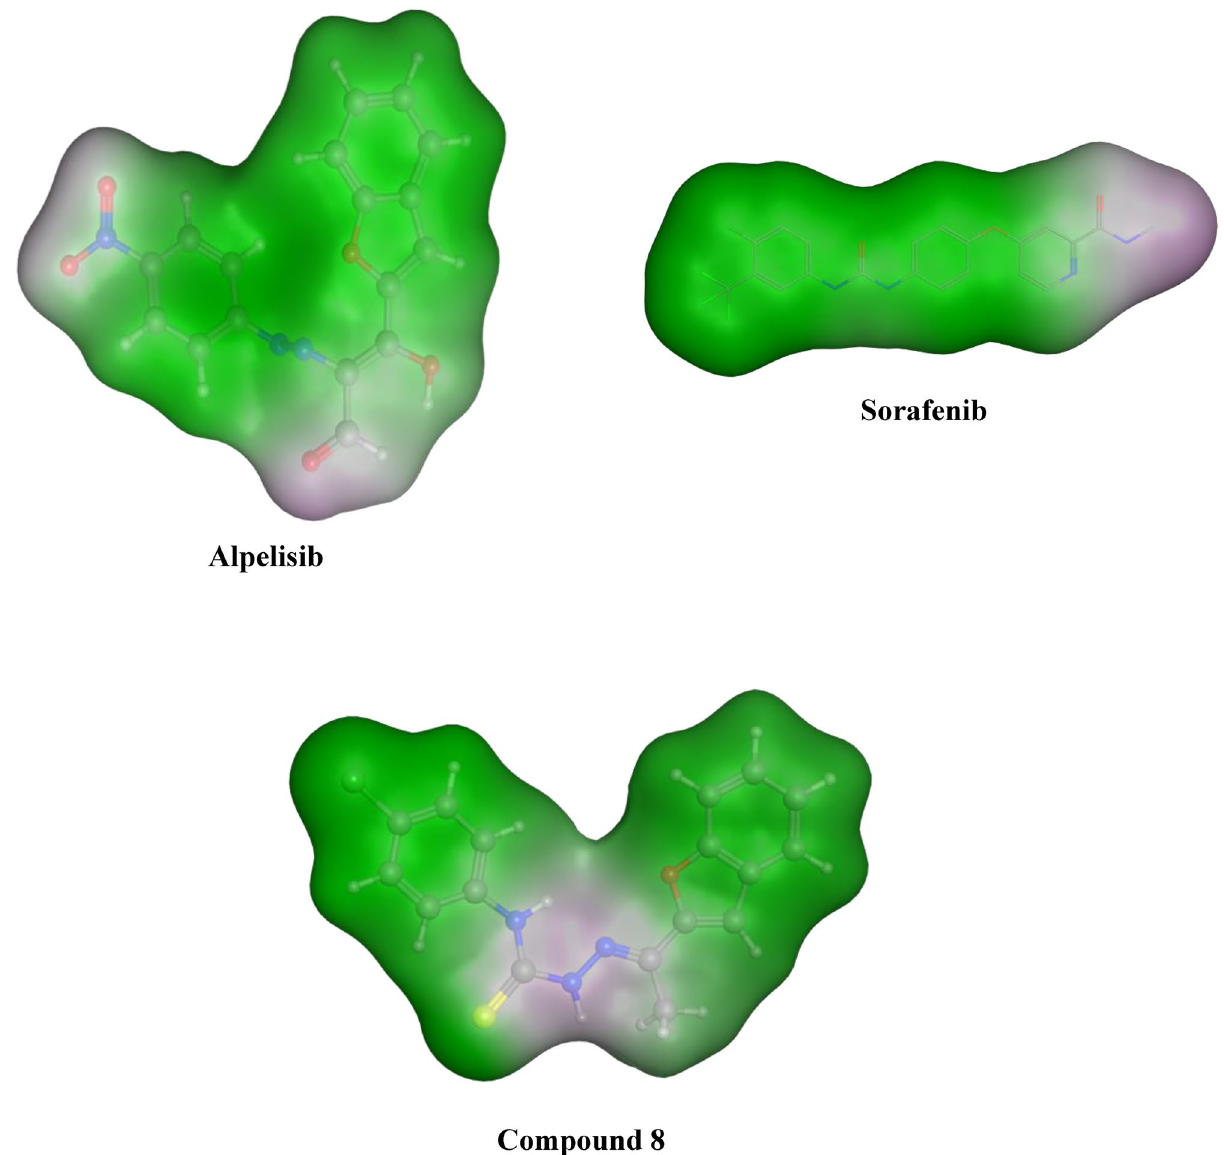
Figure 10. Surface map for alpelisib, sorafenib and compound 8 . Pink: hydrophilic, white: neutral, green